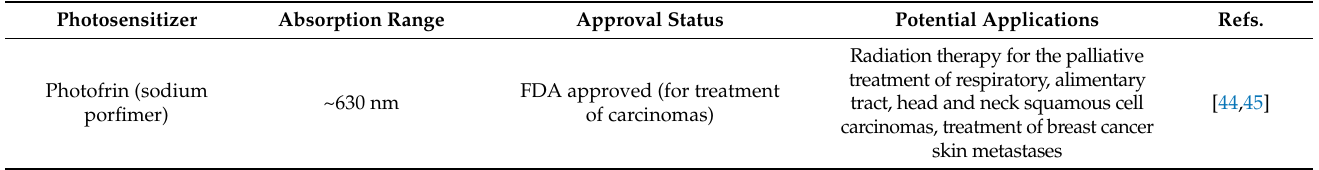
Figure 3. Modifications of PDT for increasing drug selectivity. Created based on information from literature reference [7]. Table 1. Examples of